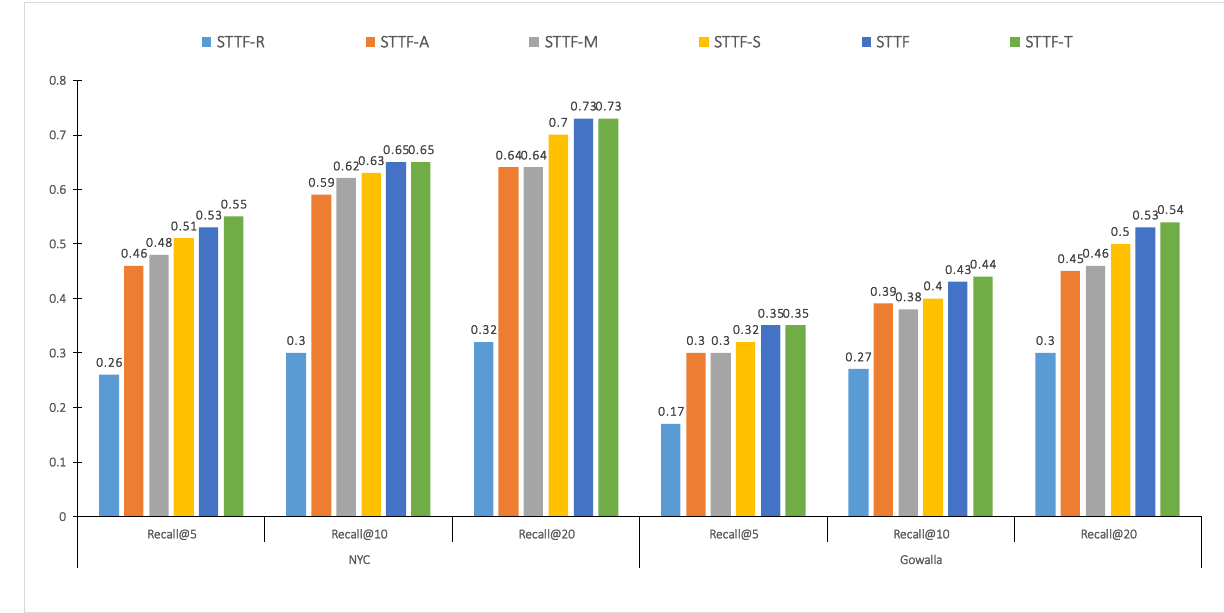
Figure 4. Ablation Analysis by Comparing Different Modules in STTF-Recommender.